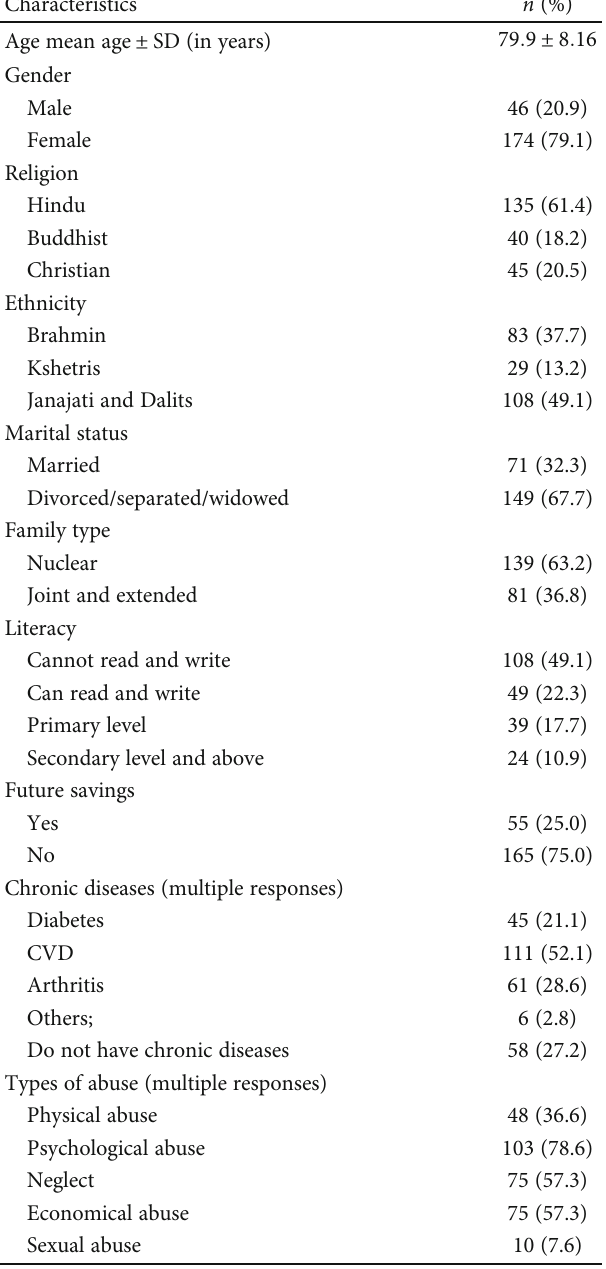
Table 1: Demographic characteristics of the respondents ( n = 220 ).